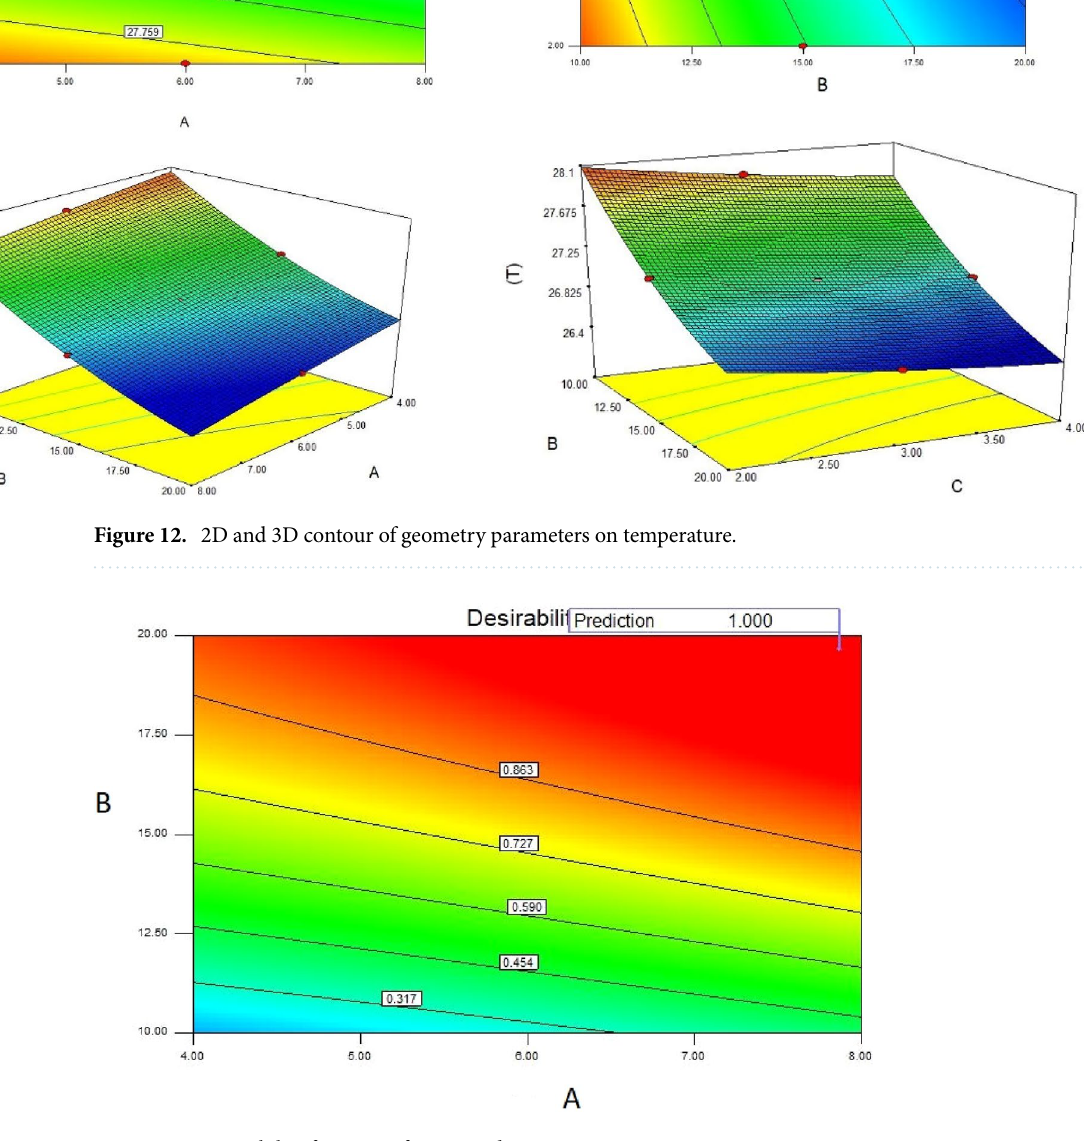
Figure 13. Desirability function of optimized